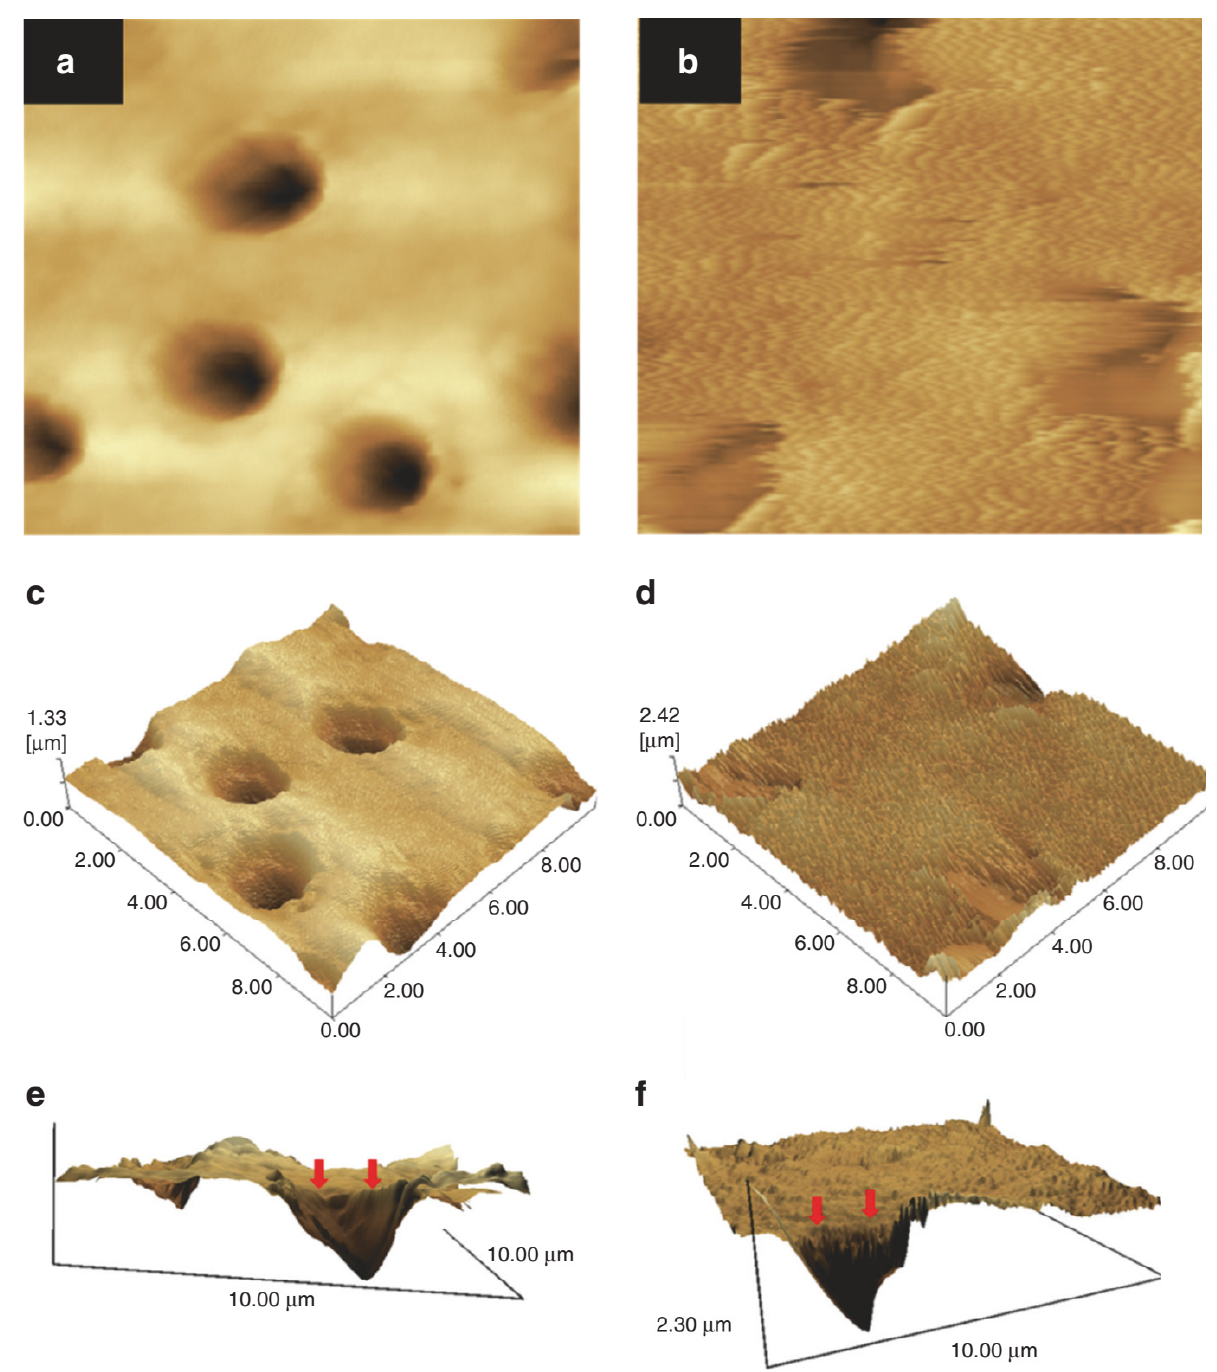
Figure 22. Representative AFM images before and after being immersed in artificial saliva for 4 weeks. AFM images of the demineralized dentin surfaces without treatment ( a , c , e ) and with the treatment of PAMAM-NH 2 ( b , d , f ) after being immersed in artificial saliva for 4 weeks. ( a , b ) are the topographical images. ( c , d ) are three-dimensional images. ( e , f ) are reconstructed from ( a , b ) by the software SPM-9700, and a horizontal plane of the remineralization surface and longitudinal profile of the dentinal tubule were observed. The control showed no mineral regeneration. In contrast, PAMAM–NH 2 induced large amounts of needle-like minerals in dentin. Reproduced under permission from [222]; adapted from [212]. Copyright: WILEY-VCH Verlag GmbH & Co. KGaA, Weinheim.